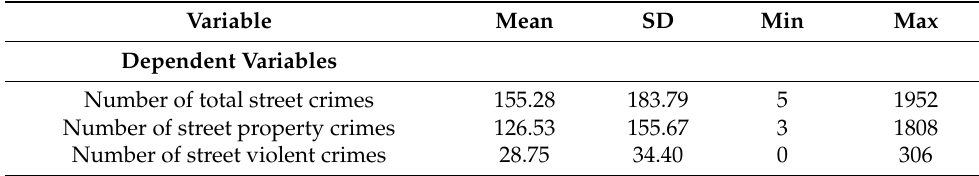
Table 1. Summary statistics of dependent and independent